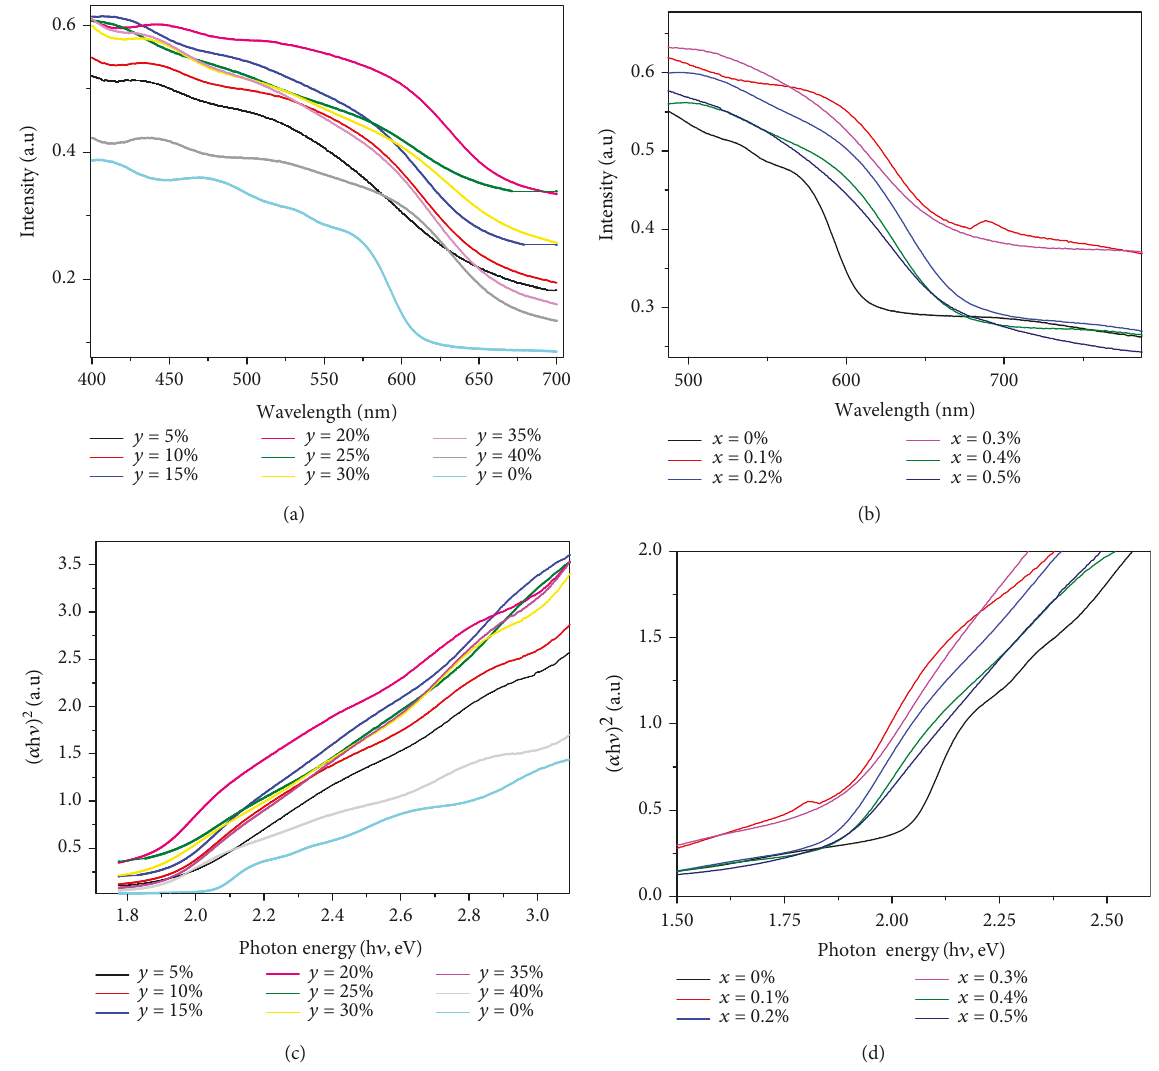
Figure 2: UV-Vis spectra of (a) CdSe(3)Mn 2+ and (b) CdSe(3)Cu 2+ . α hv 2 vs. (h ν ) curves of (c) CdSe(3)Mn 2+ and (d) CdSe(3)Cu 2+ QDs.